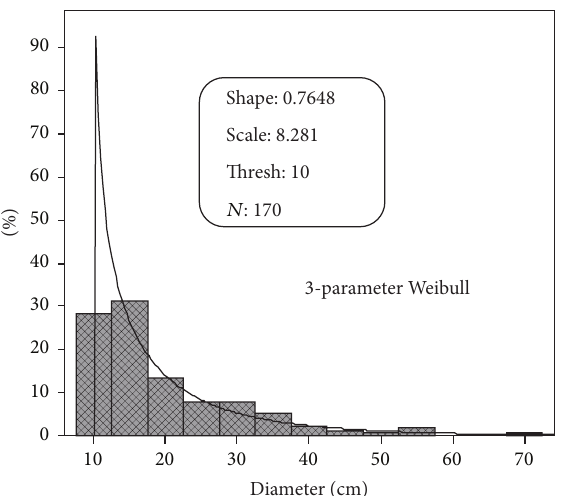
Figure 5: Height class-size distribution in the Guinean zone.